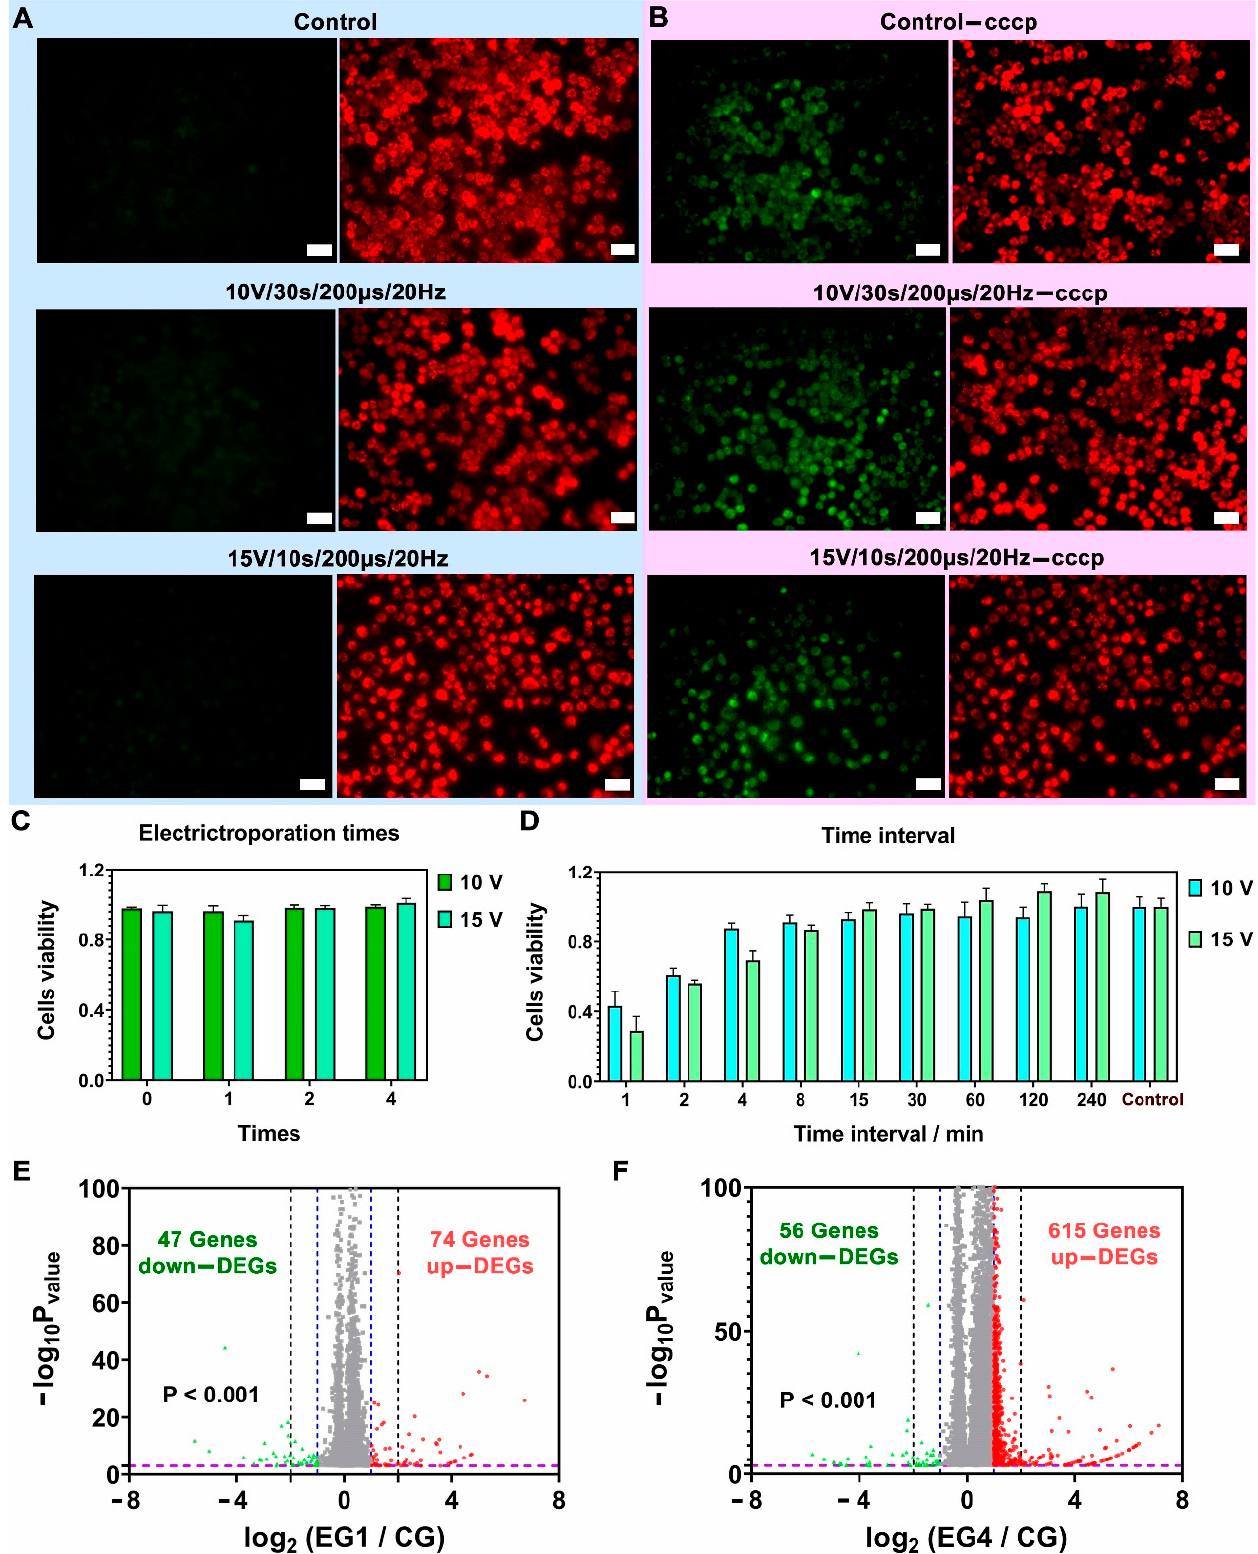
Figure 5. ( A , B ), cell apoptosis investigation after nanostraw-electroporation for 24 h, scale bar, 50 µ m. Before electroporation, all cells were cultured in device for 24 h. ( A ), Cells stained with JC-1. The red fluorescence represented healthy mitochondria, showed healthy cells; Green fluorescence showed mitochondria in poor health, represented cells tend to wither early. ( B ), Hela cells were treated with CCCP (an inhibitor of mitochondrial electron transport chain), MMP would gradually decrease after CCCP treatment. The increased green fluorescence intensity in figure ( D ) showed the early apoptosis of cells. JC-1 dye was excited at 514 nm wavelength, JC-1 aggregate was excited at 585 nm wavelength. ( C , D ), Statistical analysis diagrams of cells’ vitalities after 0-, 1-, 2- and 4-cycles nanostraw-electroporation ( C ) and electroporation with different time intervals, 1 min ~ 240 min ( D ), n = 3. 10 V group (10 V, 200 µs, 20 Hz, 30 s), 15 V group (15 V, 200 µs, 20 Hz, 10 s). ( E , F ), Volcanic maps of genes with significant expression changes of EG1 (( E ), nanostraw-electroporation once) and EG4 (( F ), nanostraw-electroporation 4 times, the nanostraw-electroporation time interval was 4 h) compared with CG (control group), n = 3. Red scatters indicated genes with up-regulated expres- sion, green scatters indicate genes with down-regulated expression, and gray scatters indicated